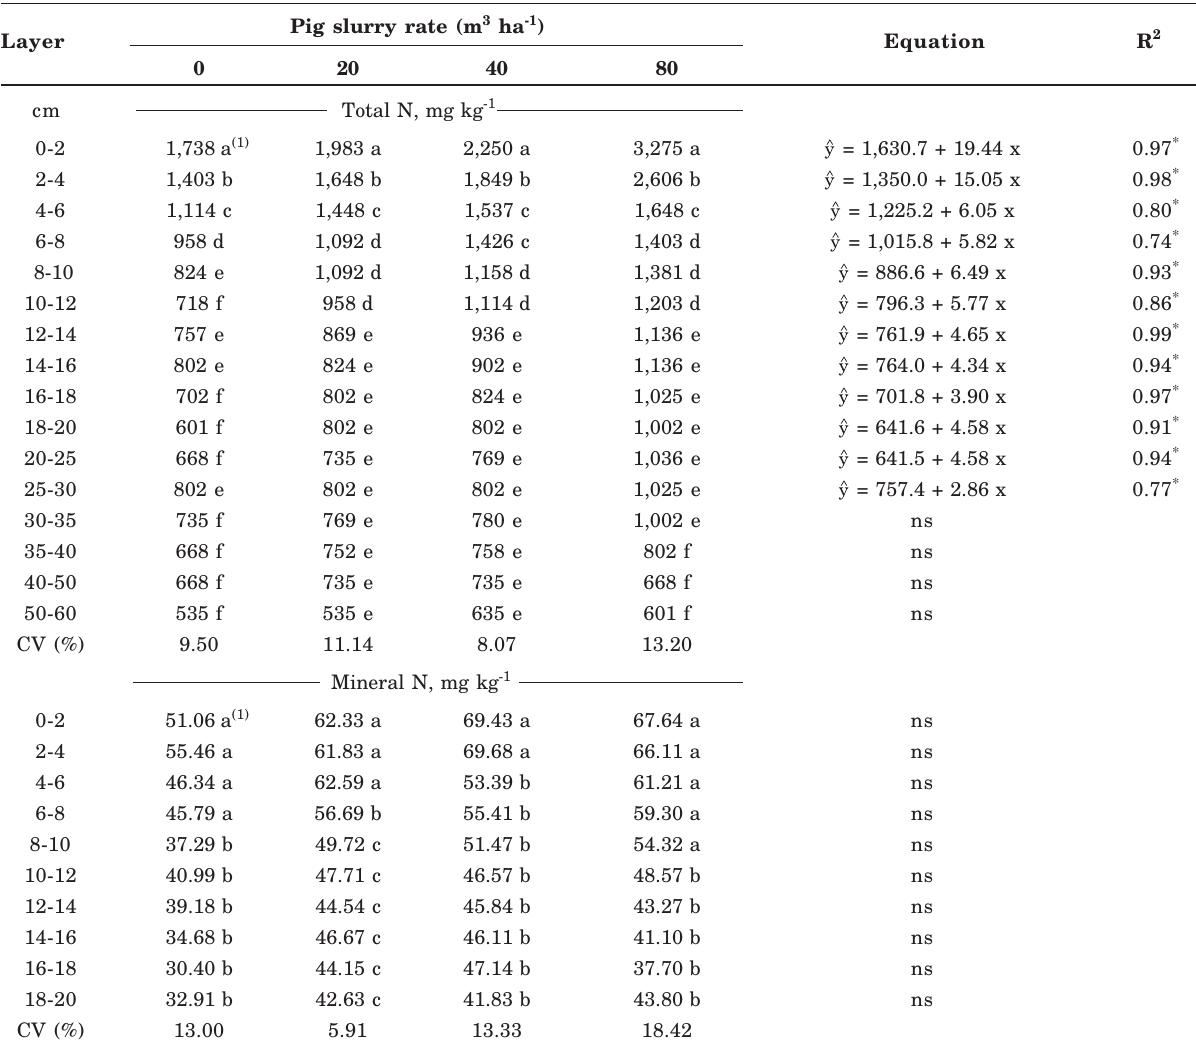
Table 3. Amounts of total and mineral nitrogen (N) in layers of Typic Hapludalf after 19 pig slurry